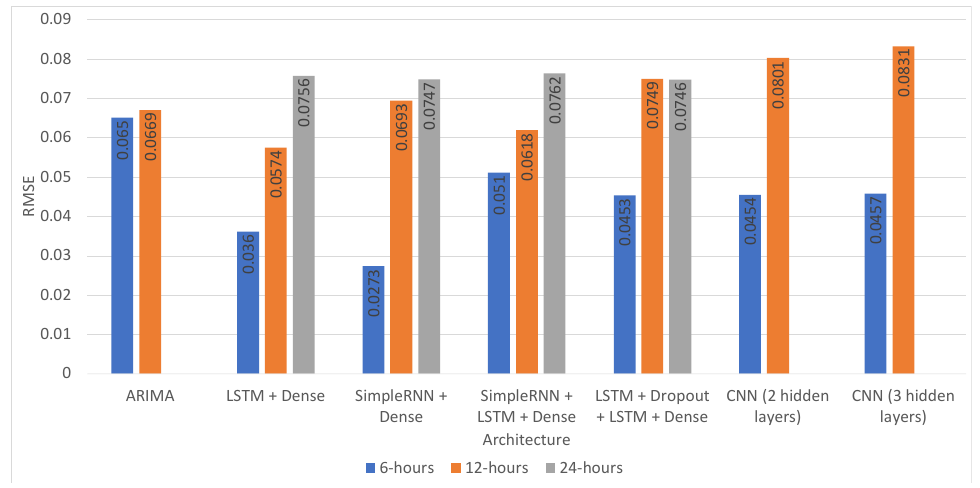
Figure 9. Performance comparison to the best models per architecture and time horizon—one year of test